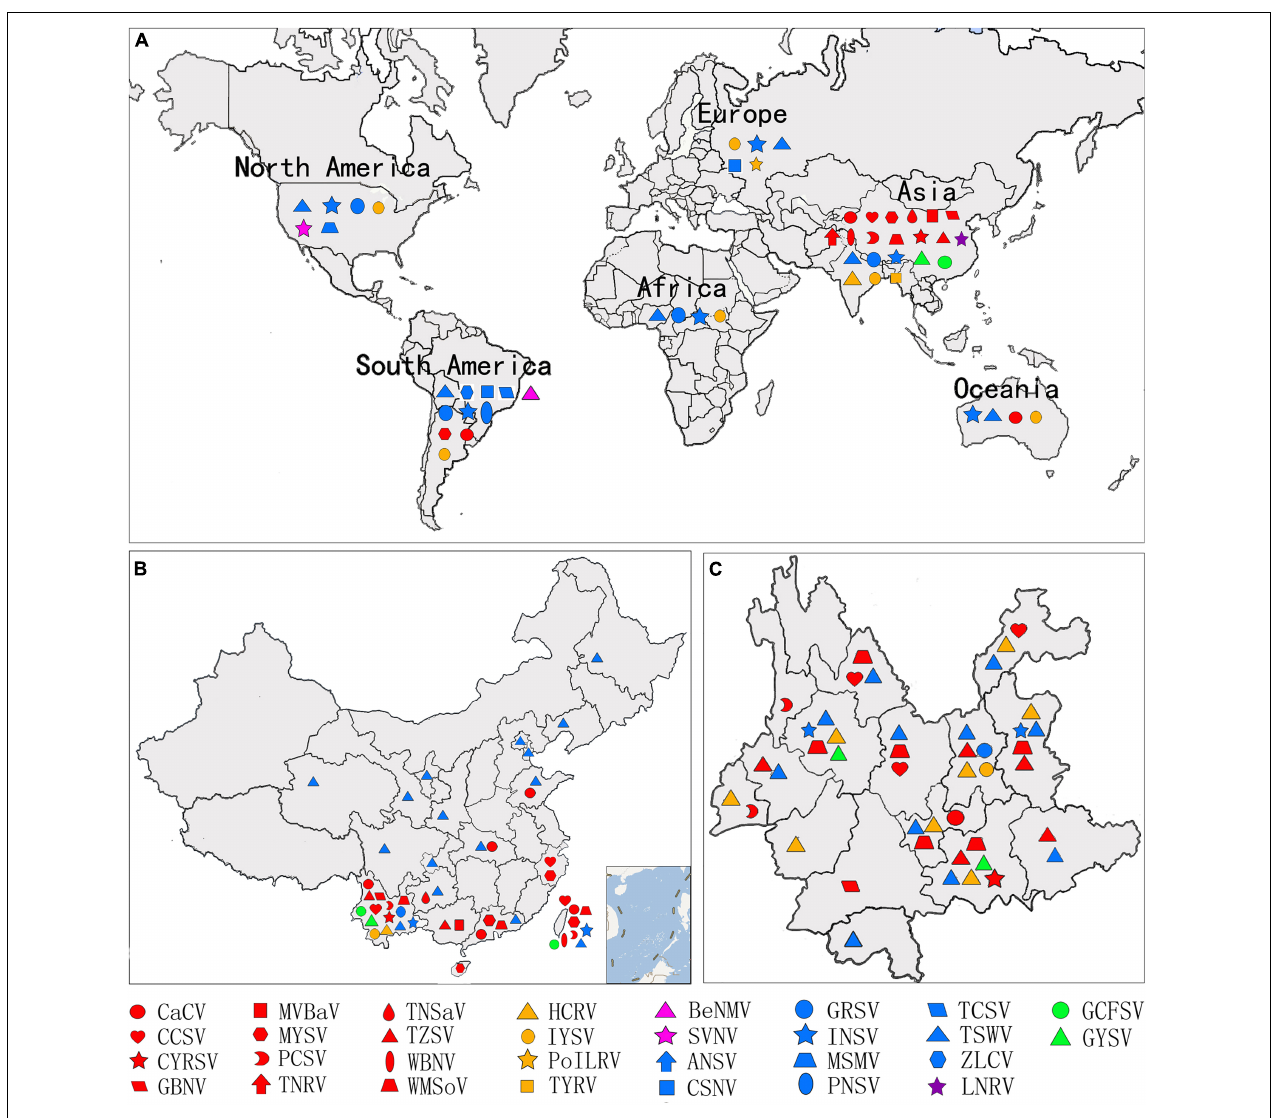
FIGURE 3 | Geographic distribution of orthotospoviruses. (A) Worldwide geographic distribution of orthotospoviruses. (B) Geographic distribution of orthotospoviruses in China. (C) Geographic distribution of orthotospoviruses in Yunnan province,